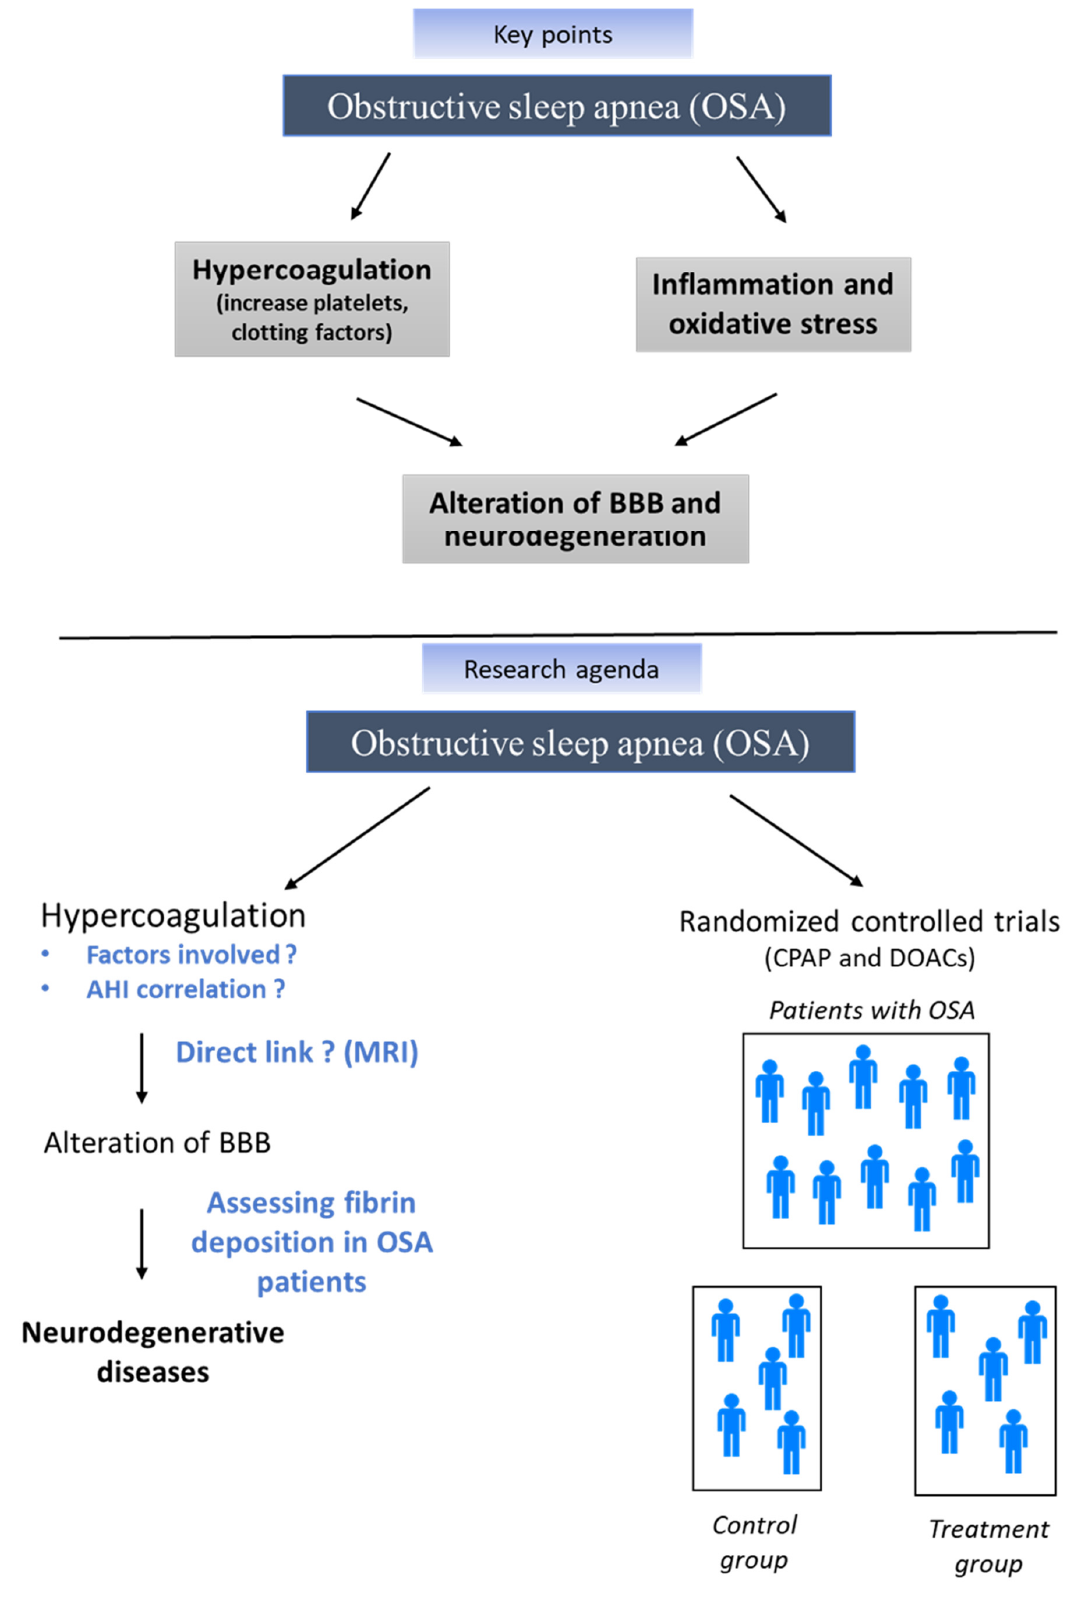
Figure 3. Key points and future directions, AHI: apnea–hypopnea index, BBB: blood–brain barrier, CPAP: continuous positive airway pressure, MRI: magnetic resonance imaging, OSA: obstructive sleep apnea.